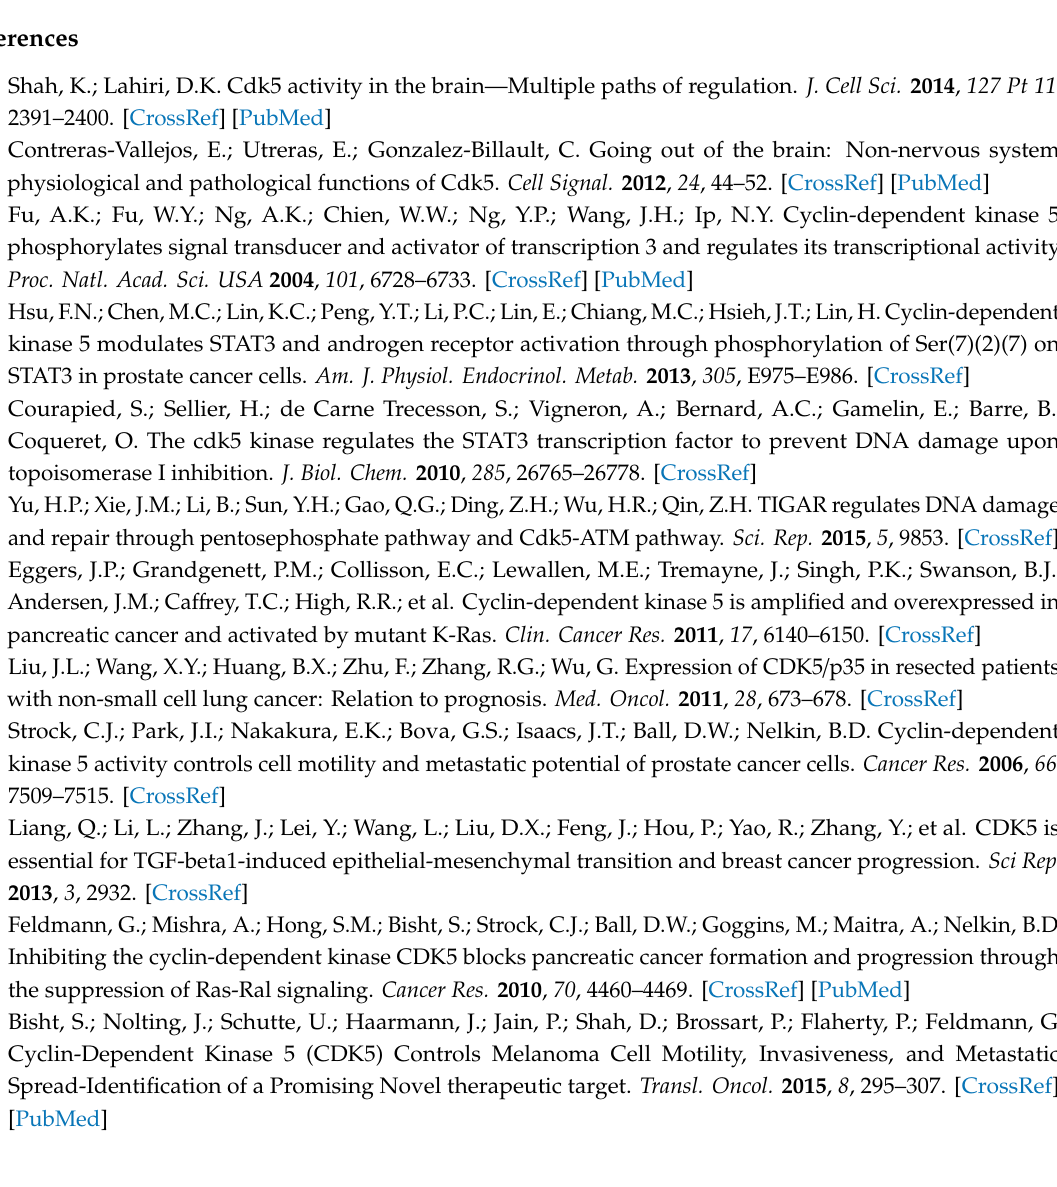
expression and CMS group, Figure S6: Images displaying non-cropped western blots from Figure 1B, Figure 3A, and Figure